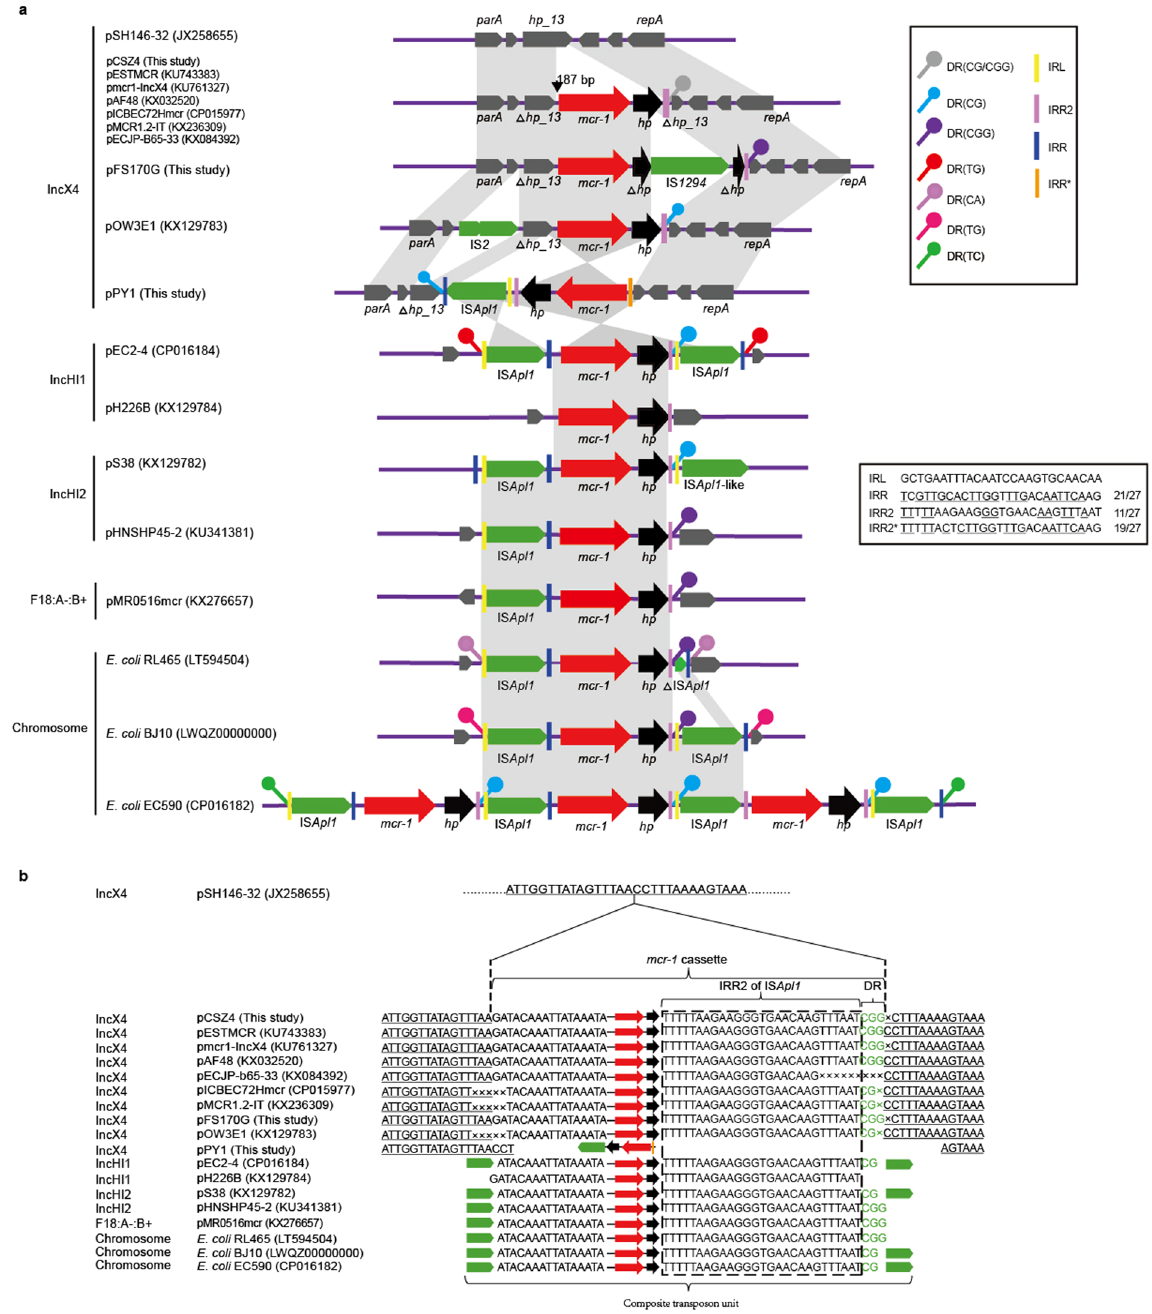
Figure 2. Contexts of mcr-1 on IncX4 plasmids and relevant the other plasmids and E. coli chromosomes. Resistance genes are indicated by red arrows, while accessory genes are indicated by gray arrows. Insertion sequences are highlighted in green arrows labelled with their name or number. DRs are represented by the filled circles. The short black arrow show the 187 bp spacer between IS Apl1 and mcr-1 . Vertical black bars represent the transposon IR of IS Apl1 , while the dotted lines indicate possible deletion and insertion events. DR, direct repeats. IRL, terminal inverted repeats of left. IRR, terminal inverted repeats of right. Underlined nucleotides in the alternate IRR elements are identical to those of the perfect IRR. The underlined bases is the backbone of pSH146-32. The big brace is the mcr-1 cassette. The bases in the box are IRRs, while the green bases are DRs. ( a ) Genetic environment of mcr-1 on IncX4 plasmids and relevant the other plasmids and E. coli chromosomes. ( b ) Alignment of the mcr-1 gene and its adjacent